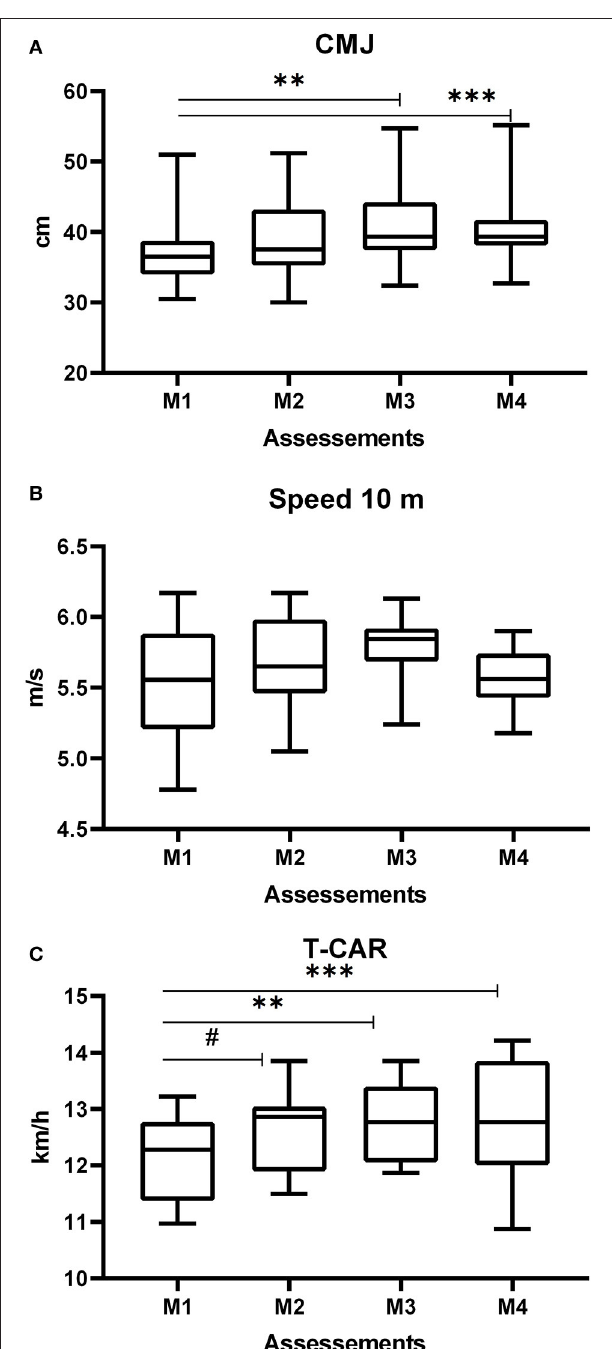
FIGURE 4 | (A) CMJ. (B) Speed 10 meters. (C) T-CAR. # Difference between M1 and M2, **Difference between M1 and M3, ***Difference between M1 and